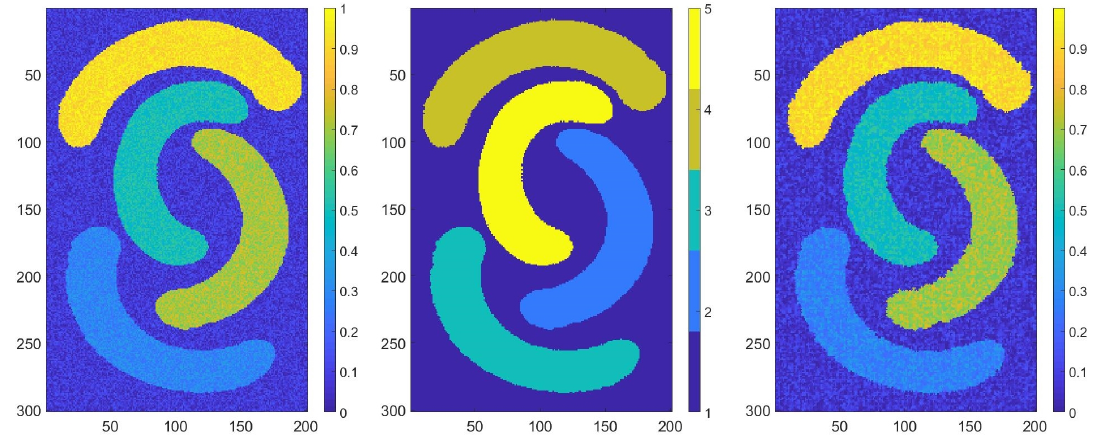
Figure 3. Synthetic data set ( left ), the corresponding ground truth ( center ) and the corresponding Voronoi diagram ( right